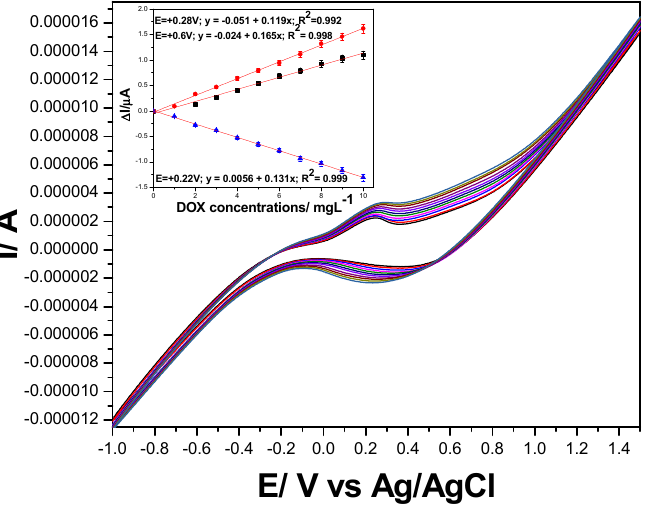
Figure 5. Cyclic voltammograms recorded at Cu/GRQD/CNT paste electrode in 0.1 M NaOH supporting electrolyte (curve 1) and in the presence of various DOX concentrations: 1–10 mg · L − 1 (curves 2–11), potential scan rate: 0.050 V · s − 1 ; potential range from − 1.00 to +1.50 V vs. Ag/AgCl. Inset: Calibration plots of current recorded at +0.280 V vs. Ag/AgCl, and +0.600 V vs. Ag/AgCl on anodic branch, and +0.220 V vs. Ag/AgCl vs. DOX concentration on cathodic branch. Table 2. Detection potential values and the sensitivity for DOX determination.